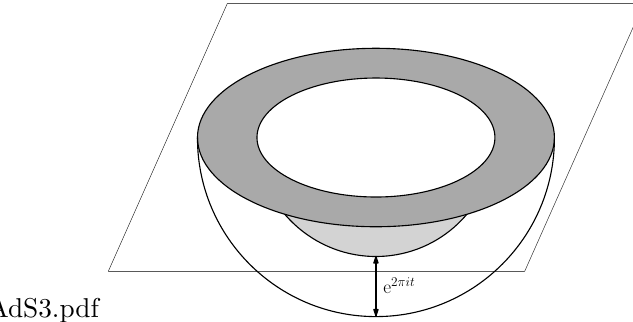
Figure 1 . Thermal AdS 3 obtained from the Schottky parametrization. Here we drew AdS 3 in Poincaré coordinates. The boundary is the plane indicated in the figure, while the bulk extends underneath the plane. The fundamental domain of the group action (2.3) on the boundary is an annulus, which is depicted in dark gray. In the bulk, the orbifold action identifies the two hemispheres that extend from the inner and outer circle of the annulus. The resulting space is fibred by hemispheres that bound circles in the annulus. Thus, it is topologically a disk times a circle, i.e. a solid torus. The non-contractible cycle corresponds to the radial direction on the boundary, i.e. to time in radial